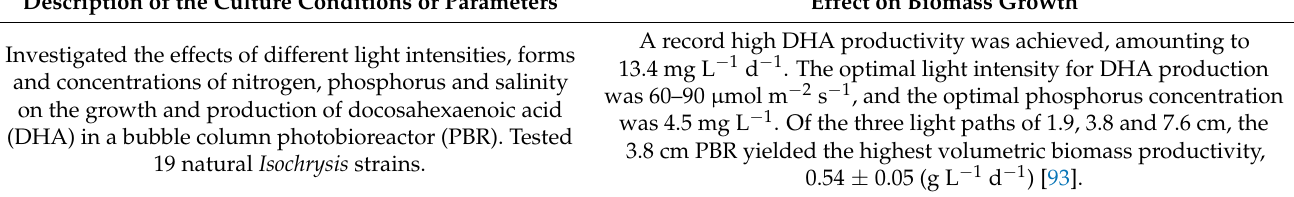
Table 8. Cont. Description of the Culture Conditions or Parameters Effect on Biomass Growth Investigated the effects of different light intensities, forms and concentrations of nitrogen, phosphorus and salinity on the growth and production of docosahexaenoic acid (DHA) in a bubble column photobioreactor (PBR). Tested 19 natural Isochrysis